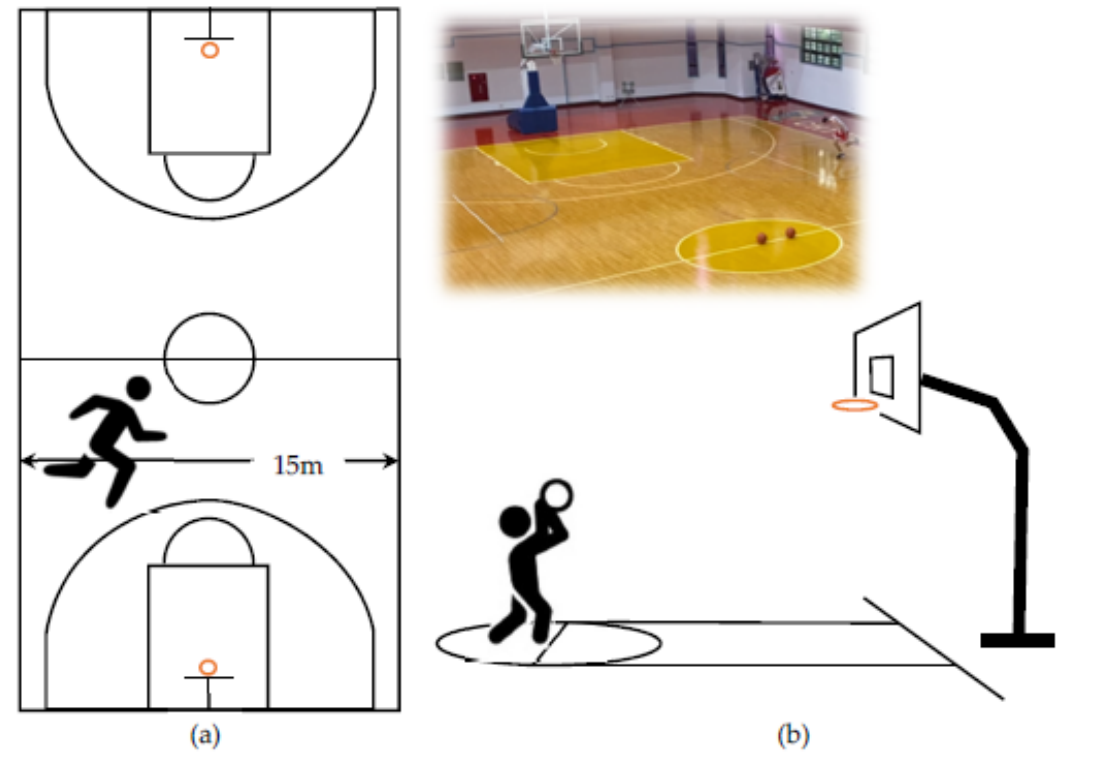
Figure 2. Tasks ( a ) Shuttle runs in 60 s (time-limited) and ( b ) Shoot 10 goals from the free-throw line (scores to achieve).